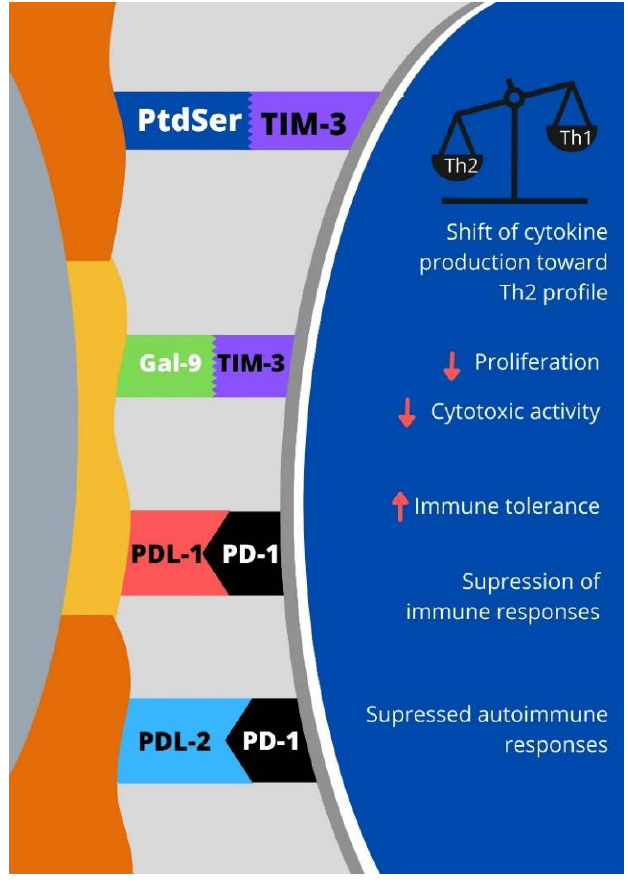
Figure 2. Interactions and their effects between immune checkpoints and their ligands expressed on immunocompetent cells with effector mechanism: PD-1—programmed cell death protein 1, TIM-3—T cell immunoglobulin-3, PDL-1—programmed death-ligand 1, PDL-2—programmed death-ligand 2, PtdSer—phosphatidyl serine, Gal-9—galectin-9.